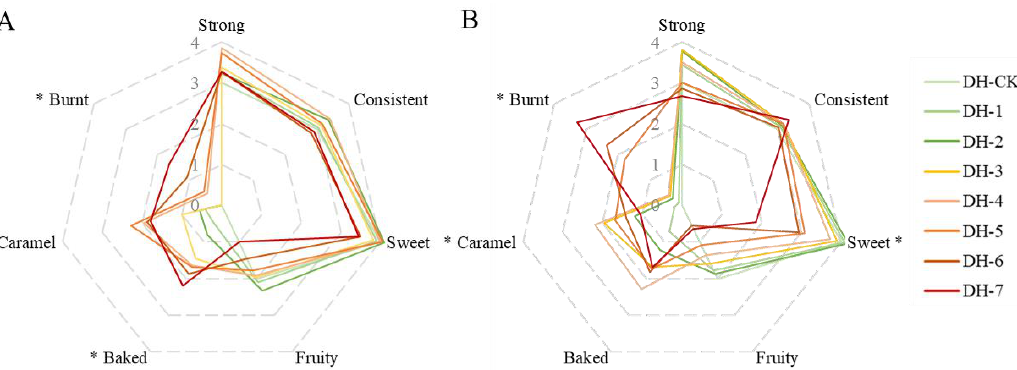
Figure 2. Radar diagrams of the mean sensory attributes scores of Yunnan congou black teas with different aroma-enhancement conditions. ( A ) Radar diagram of aroma-enhanced Yunnan congou black teas baked at 90 °C for 0 – 7 h. ( B ) Radar diagram of aroma-enhanced Yunnan congou black teas baked at 100 °C for 0 – 7 h. * indicates significance at p < 0.05. Note: DH — black tea sample of Yunnan congou black tea; DH-CK — unbaked black tea; DH-1 – 7 — black tea baked for 1 – 7 h, respec- tively.